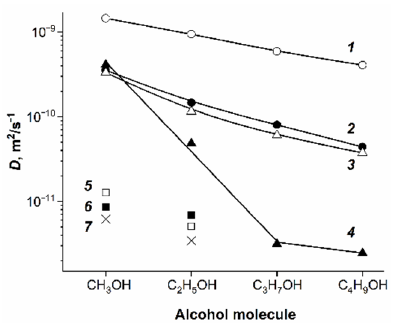
Figure 38. Diffusion coefficients of methanol, ethanol, propanol, and butanol in bulk liquids (1) and MF-4SC membranes in different ionic forms: Li + (2); H + (3); Na + (4); Cs + (5); Rb + (6); K + (7) (adapted from [45]). * Bulk water self-diffusion coefficient at 25 °C is 2.3 × 10 −9 m 2 /s, bulk methanol self-diffu- sion coefficient at 25 °C is 2.4 × 10 −9 m 2 /s.